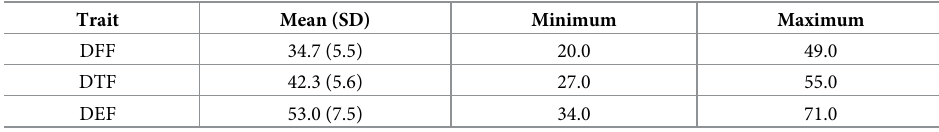
Table 1. Summary statistics for phenological traits in the common bean. Trait